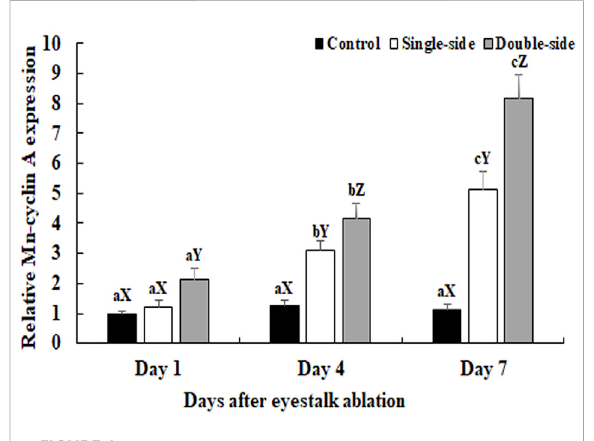
FIGURE 1 Measurementofthe Mn - CycA expressionsaftertheablations of single-side and double-side eyestalk from male M. nipponense by qPCR. The amount of Mn-CycA mRNA was normalized to the EIF transcript level. Data are shown as mean ± SD (standard deviation) of tissues from three separate individuals. Lowercases indicate expression difference between different days in the same group( p < 0.05).Capitallettersindicatedtheexpressiondifference between different groups at the same day ( p < 0.05).